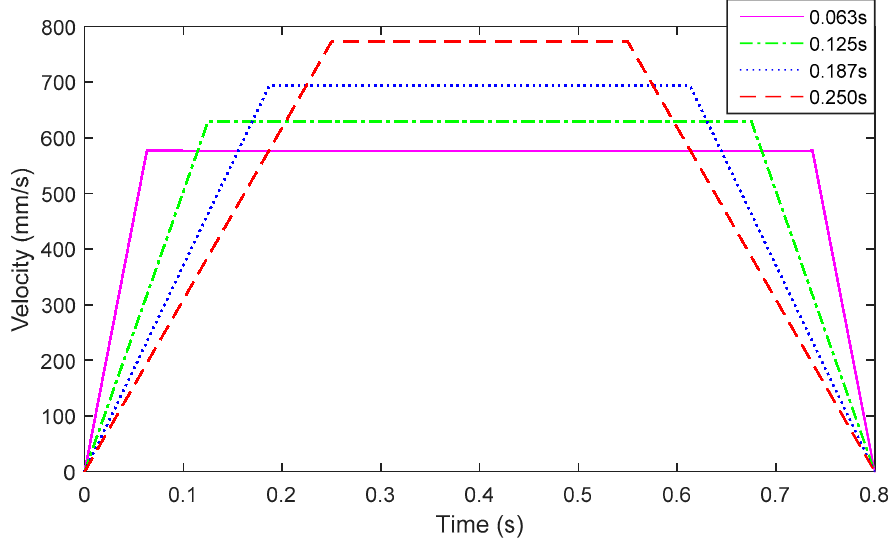
Figure 19. The velocity profiles when moving 425 mm over 0.8 s. Table 5. Experimental results of maximum amplitude and settling time when moving 425 mm over 0.8 s.